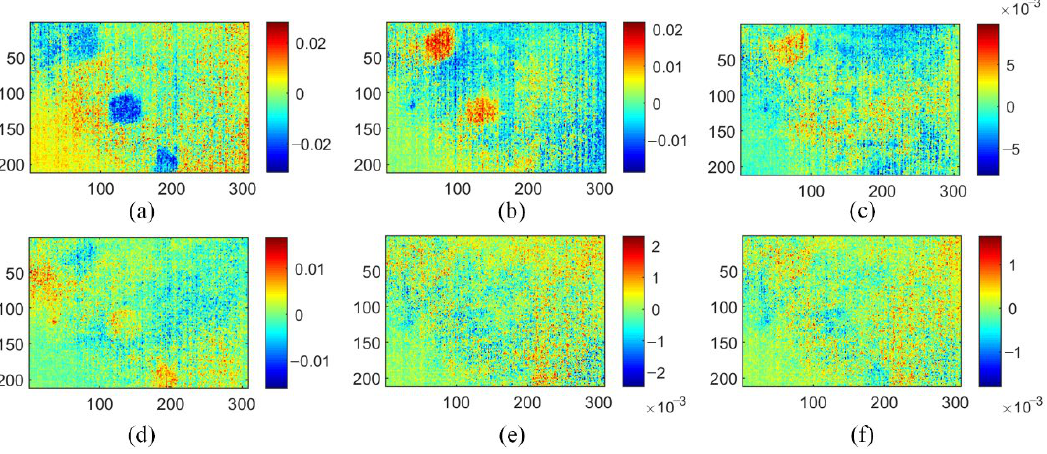
Figure 8. Analysis results of MLT method on three-defective CFRP sample: ( a ) IV1; ( b ) IV2; ( c ) IV3; ( d ) IV4; ( e ) IV5; ( f ) IV6.